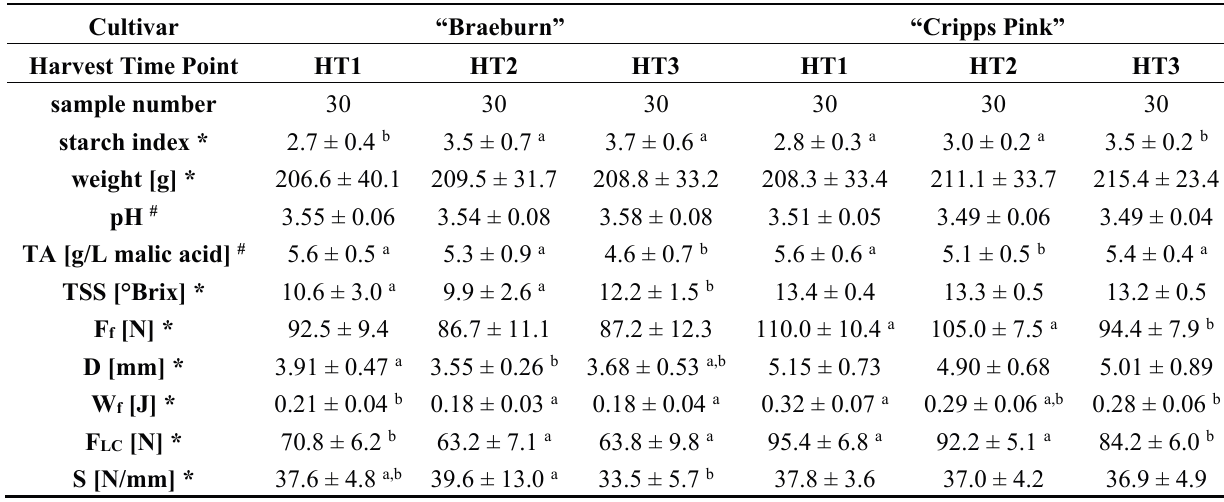
Table 1. Quality parameters (mean ± standard deviation) determined at harvest in “Braeburn” and “Cripps Pink”